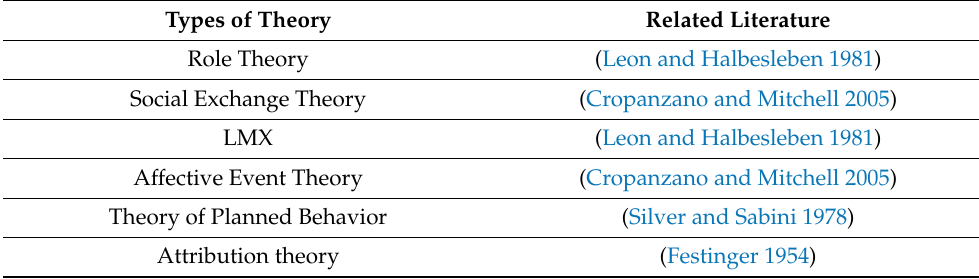
Table 1. Analysis of the application of leadership